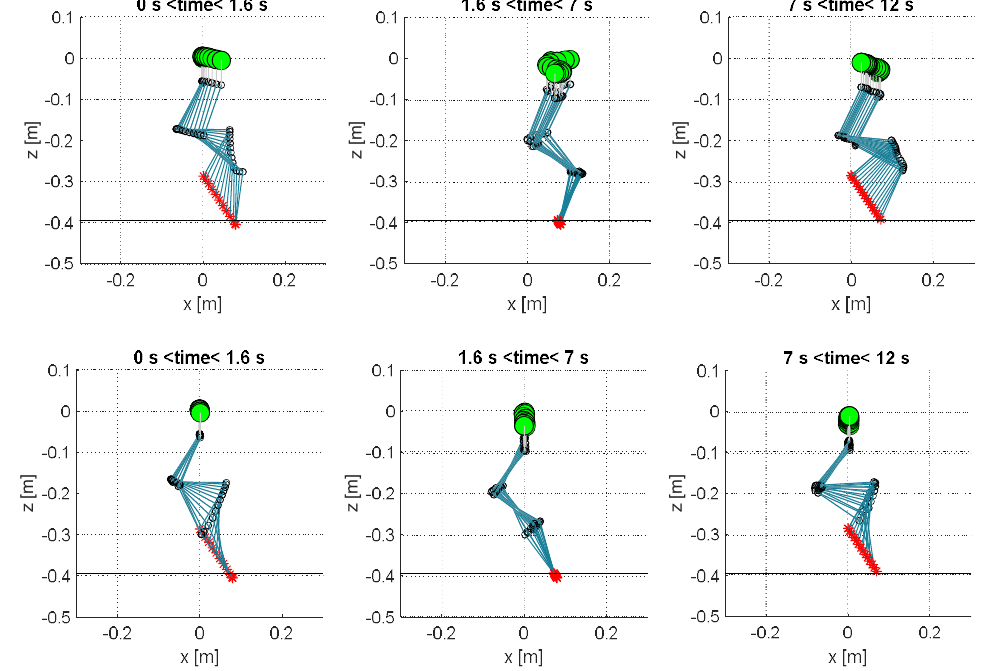
Figure 22. Stroboscopic trajectories for the load picking task for the 3-DOF redundant UAM using the generalized Jacobian with external forces ( top ) and using the extended generalized Jacobian ( bottom ). The left column shows the forward motion until the start of the grasping, the central one shows the slow load lifting part, and the right one the fast part of the backward motion. The UAV base is the large green marker, joints are the black circles, links are the blue lines, and end-effector positions tracked are the red crosses; the black line shows the height of the undeformed contact spring ( z = z S